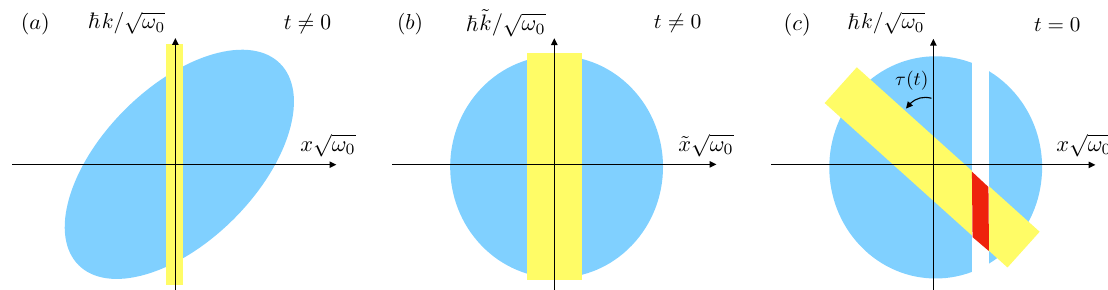
Figure 7: Wigner probability distribution in the harmonic trap after a generic har- monic protocol. Panel (a): The probability of having a particle at position x = 0 at t (cid:54) = 0 is proportional to the area of the yellow strip. Panel (b): Using the scaling approach, such strip gets a rescaled in the coordinates ˜ x = x / b ( t ) and ˜ k = ( kb ( t ) + x ˙ b ( t )) . Note that in these variables the Wigner function is just a circle. Panel (c): In the original variables, the tilded coordinates just rotates, giving the ro- tated yellow strip. If at initial time we remove a particle at a given position x (cid:54) = 0, the probability of creating a new one at x = 0 at time t is proportional to the red